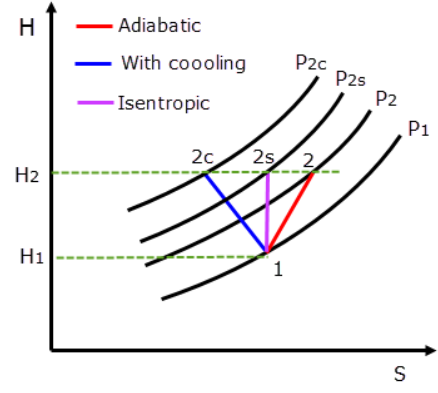
Figure 7 . Enthalpy ‐ entropy diagram for the compression process with different thermal conditions. Figure 8. Effect of cooling different walls on the impeller temperature.